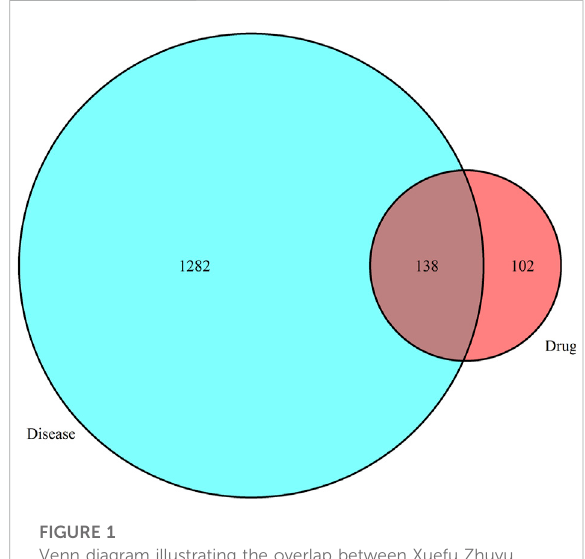
FIGURE 1 Venn diagram illustrating the overlap between Xuefu Zhuyu Decoction and atherosclerosis